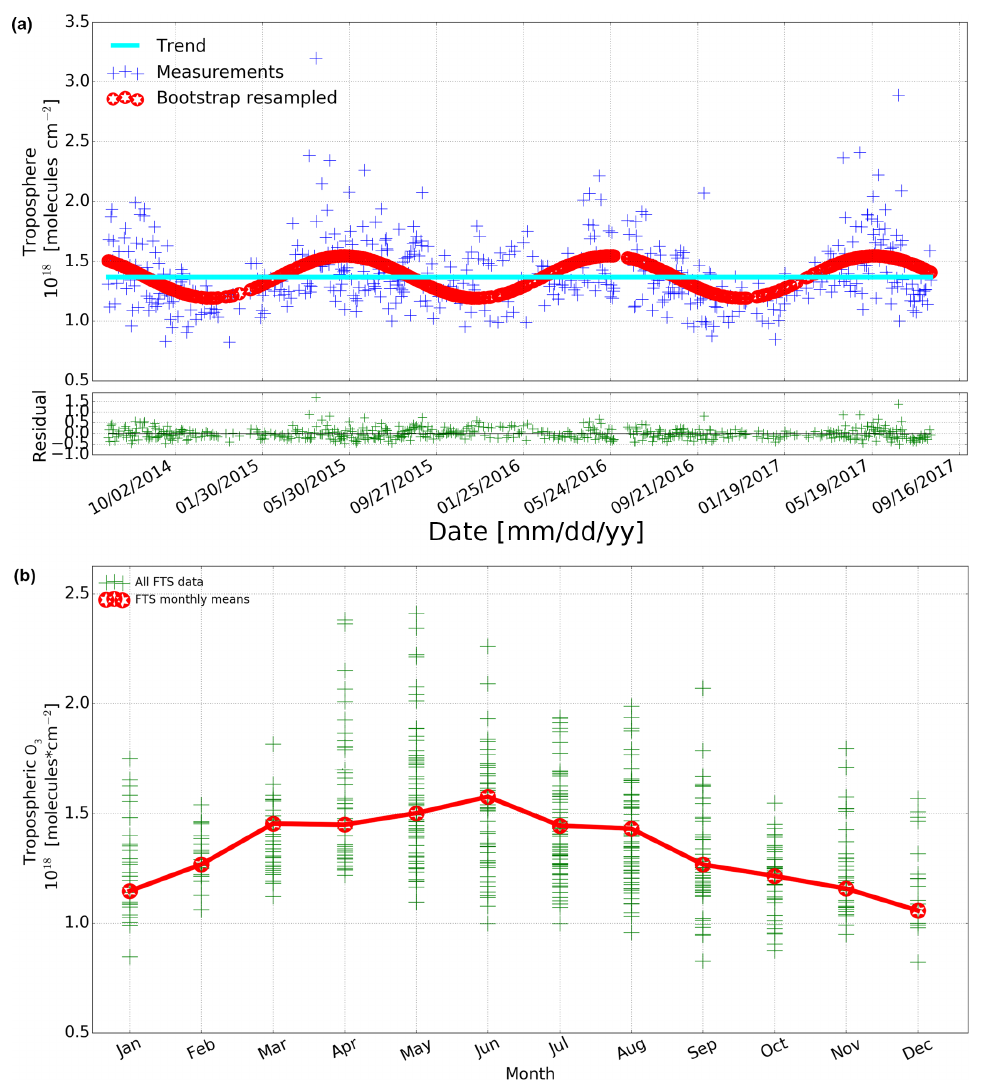
Figure 1. (a) FTS measured and bootstrap resampled tropospheric O 3 columns at Hefei site. The linear trend and the residual are also shown. Detailed description of the bootstrap method can be found in Gardiner et al. (2008). (b) Tropospheric O 3 column monthly means derived from (a)